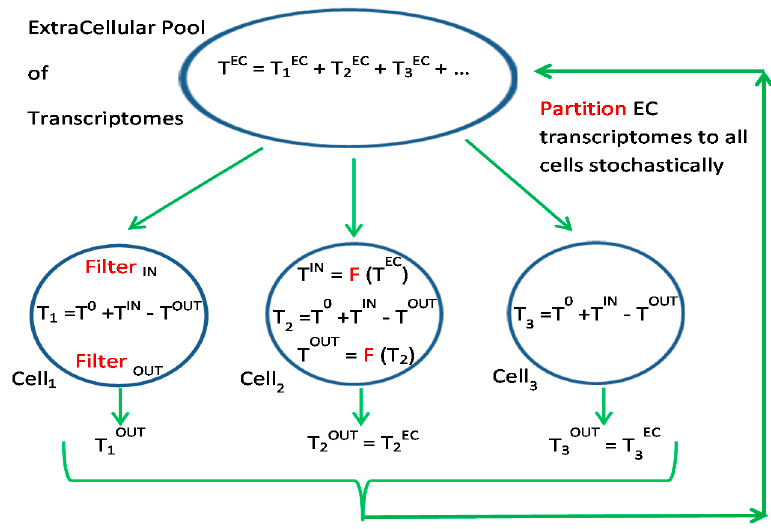
Figure 2. Transcriptomes partitioned into cells or membrane bound computer programs. Within cells there can also be compartmentalization of transcripts leading to functional modules. Filter function F operates bidirectionally upon RNA transcripts using semantic operators.